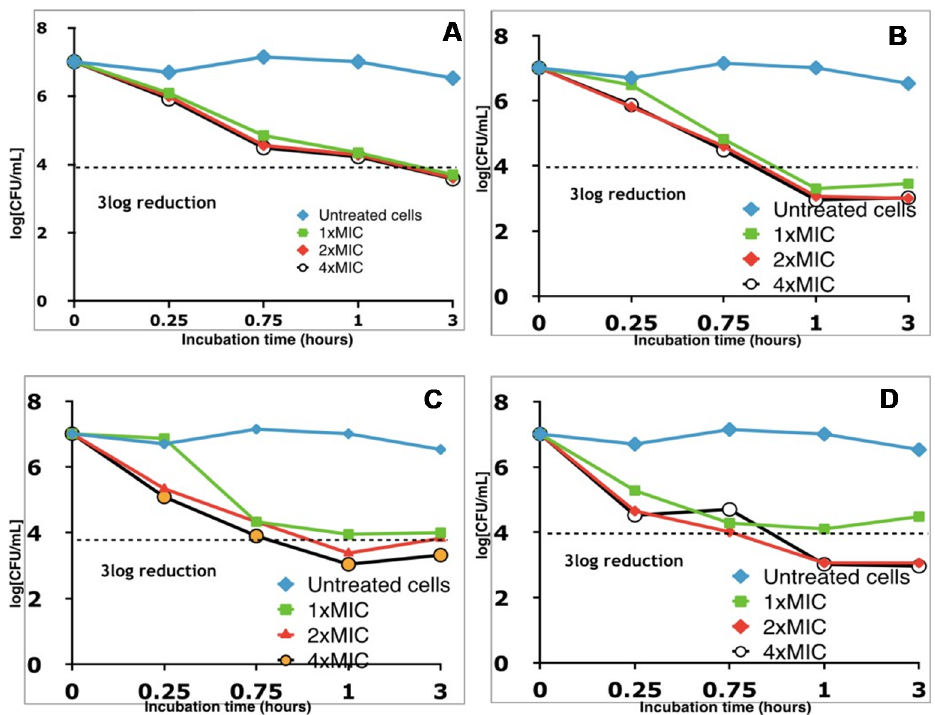
Figure 2. Time–kill study of sophorolipid ester derivatives against B. cereus : ( A ) lactonic SL; ( B ) SL-methyl ester; ( C ) SL-propyl ester; ( D ) SL-butyl ester.